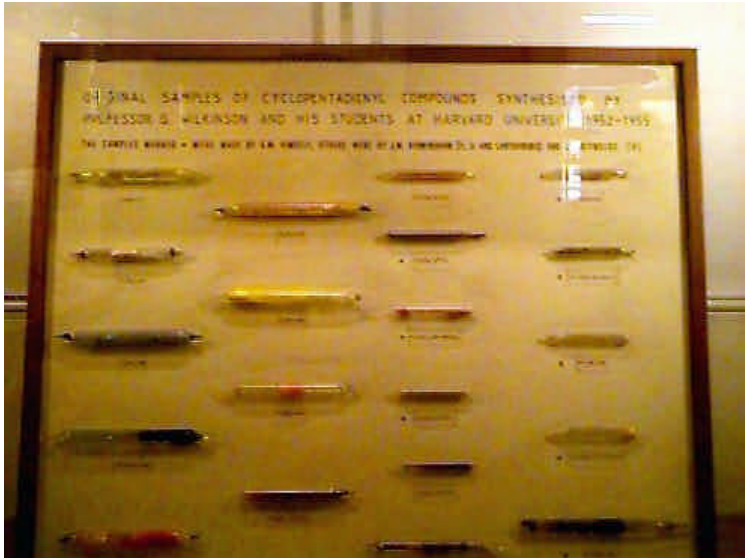
Figure 6. Wilkinson's